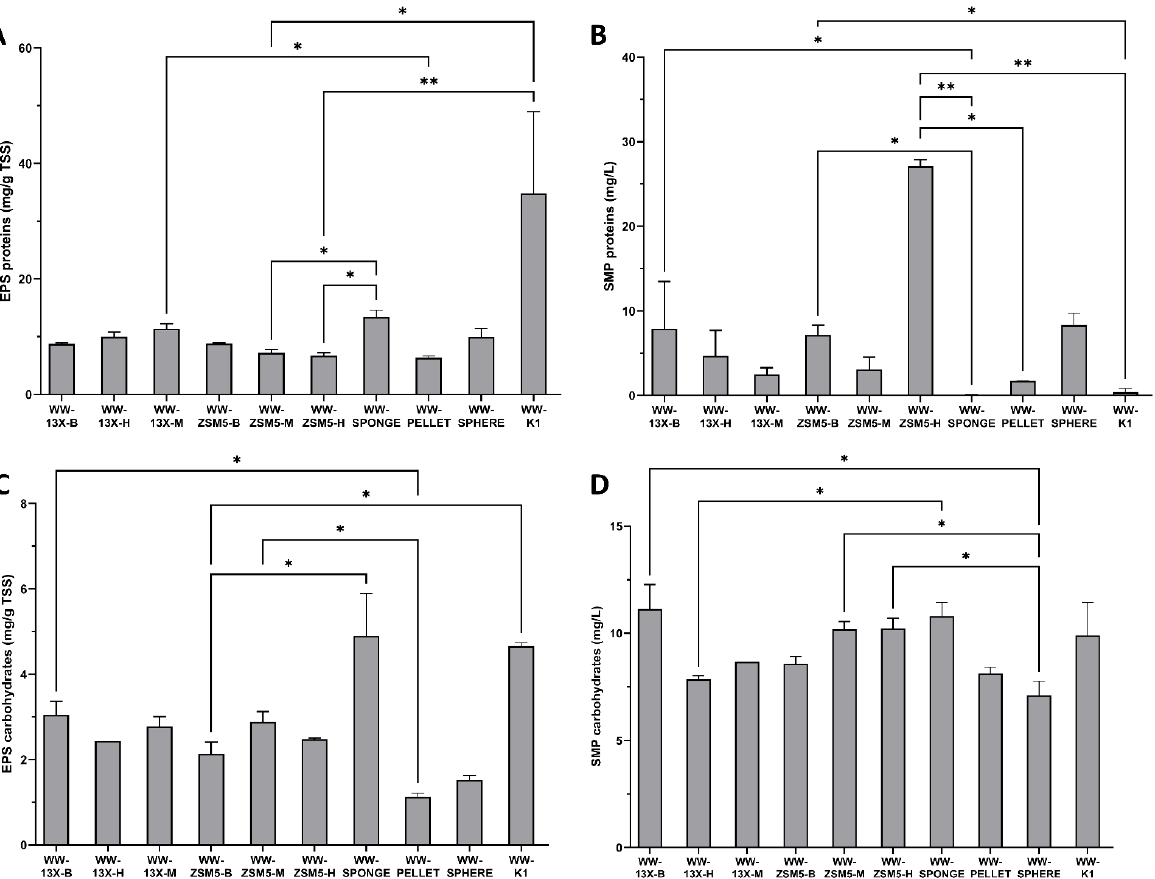
Figure 7. Bar diagrams of Soluble Microbial Products (SMP) and Extracellular Polymeric Substances (EPS) for WW biocarriers. ( A ) EPS proteins, ( B ) SMP proteins, ( C ) EPS carbohydrates, ( D ) SMP carbohydrates. ** p < 0.01; * p < 0.05. n = 3.